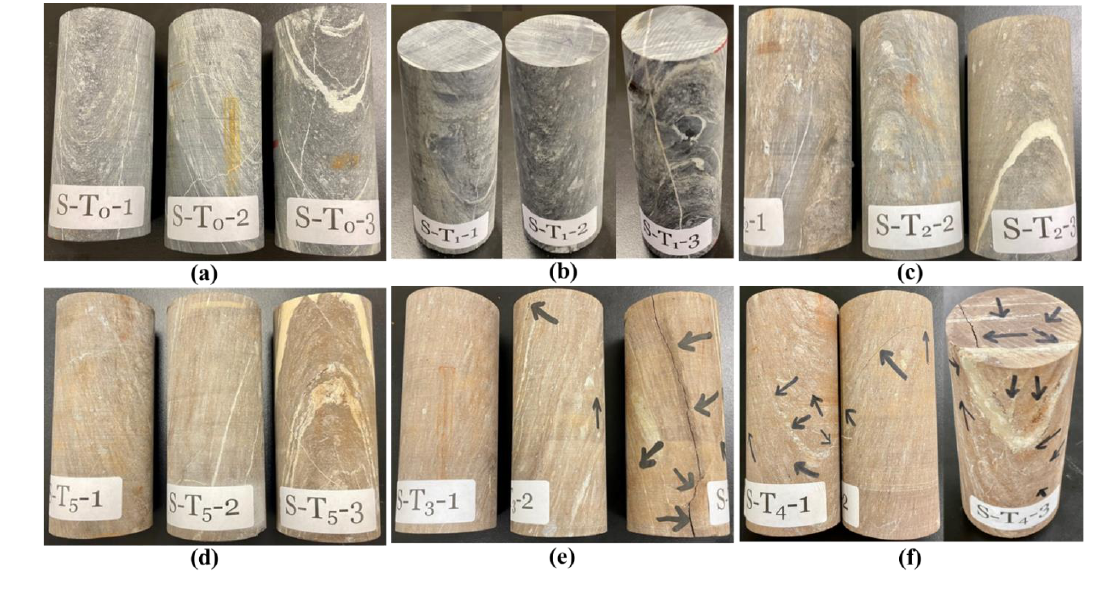
Figure 12. Crack observation of the samples at different temperatures ( a ) 22 ◦ C, ( b ) 200 ◦ C, ( c ) 400 ◦ C, Table 4. Volume of permeable pore space (voids, %).